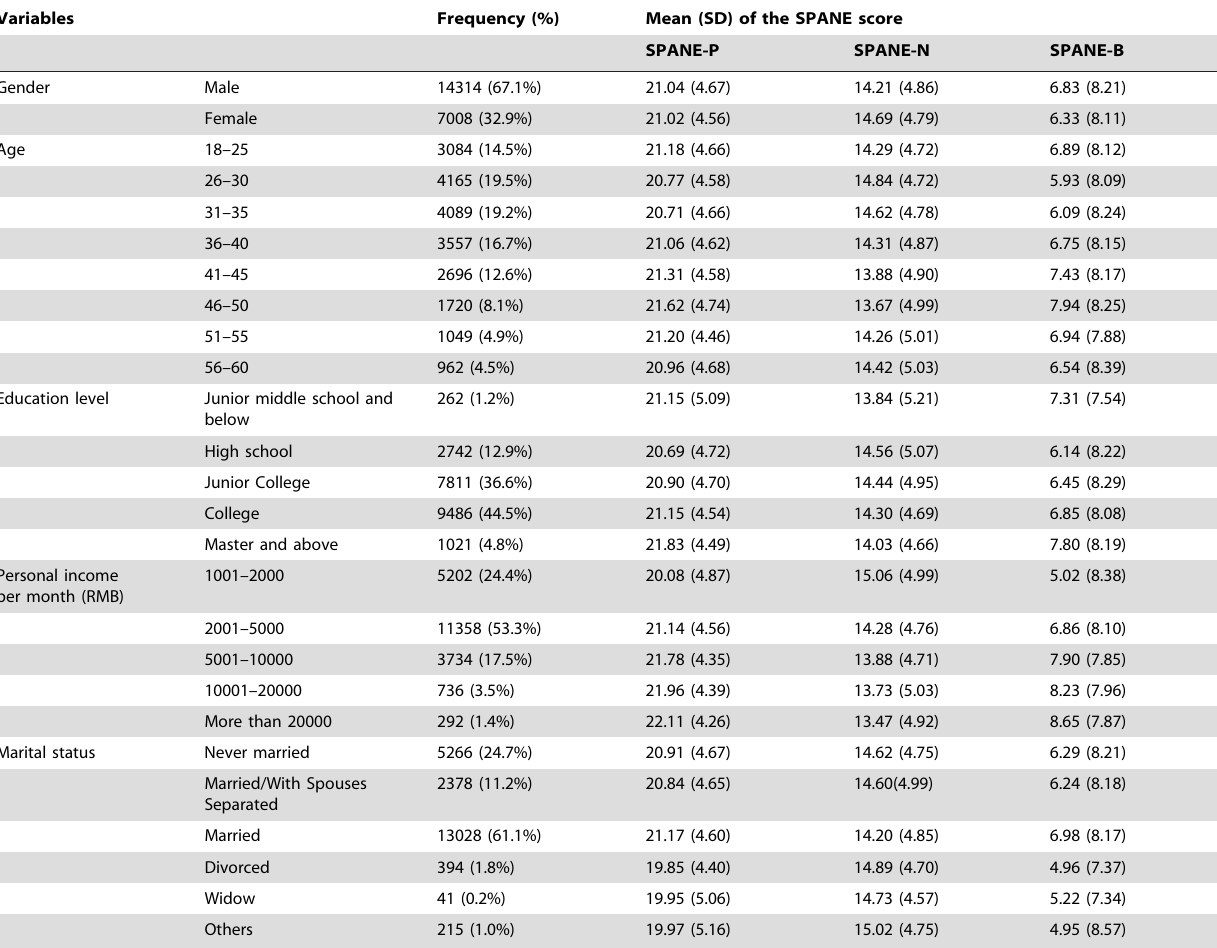
Table 1. Participants’ demographic data and SPANE scores ( N =21,322